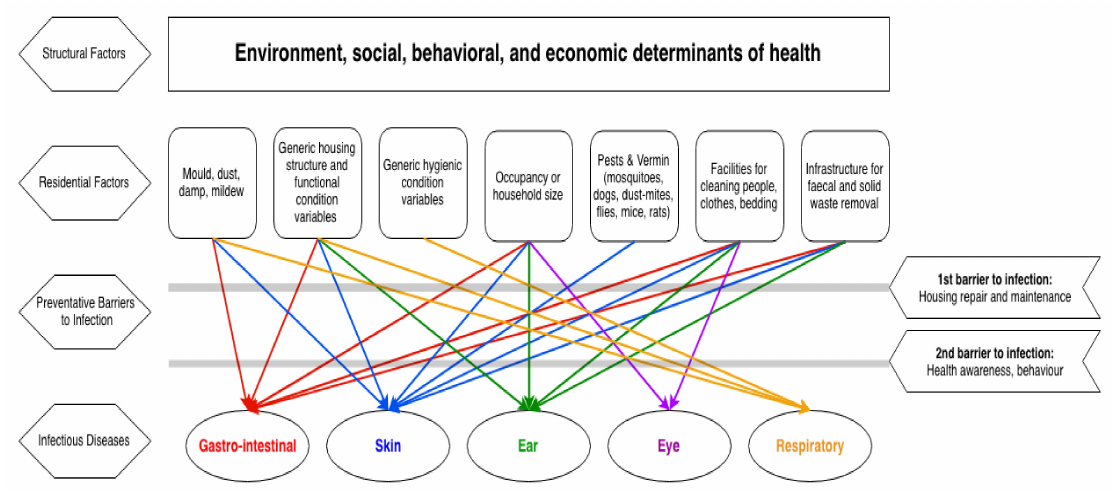
Figure 2. Systems approach to explain links between housing and infectious diseases. Sources: